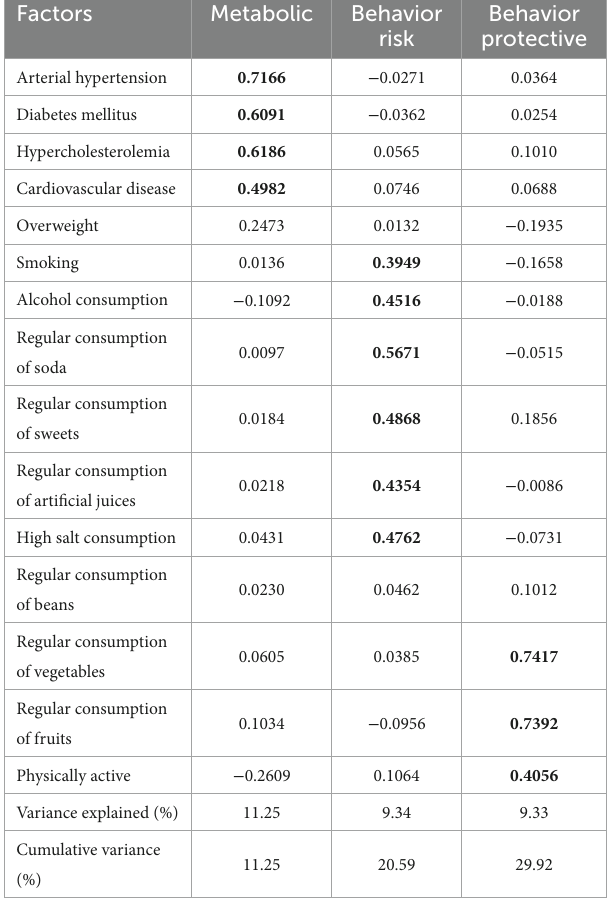
TABLE 2 Factor structure of metabolic, behavior risk and behavior protective in the Brazilian population. PNS, 2019.